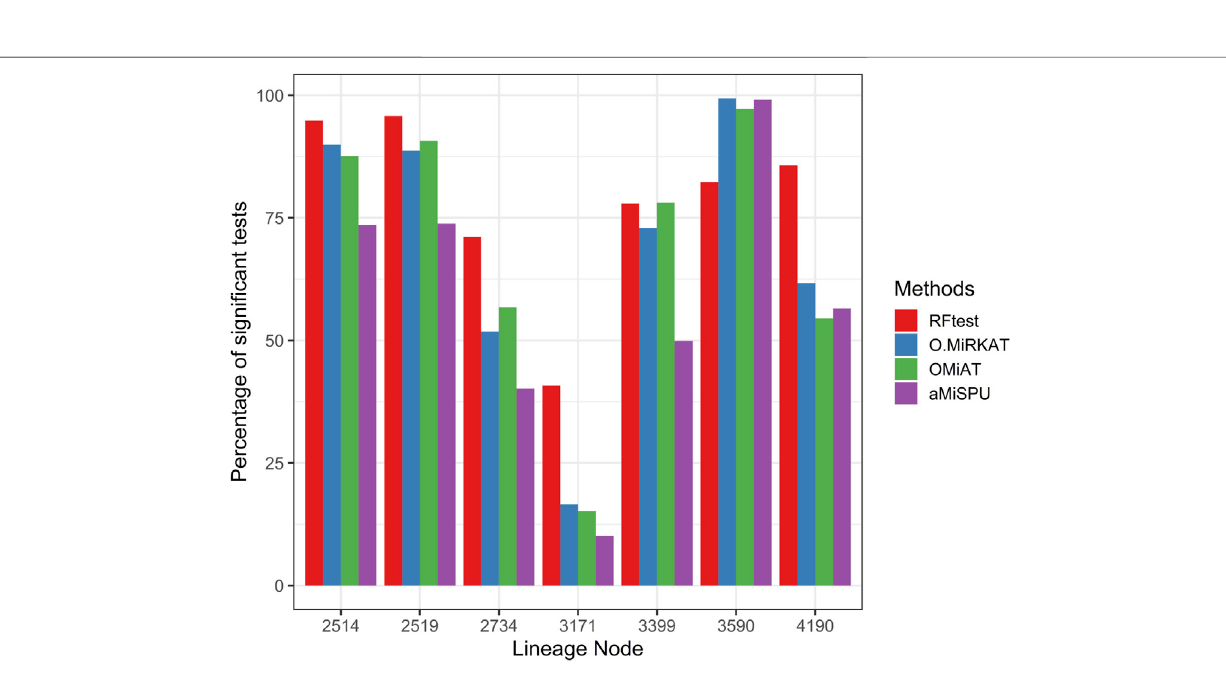
FIGURE2| Powercomparisonamongthefourcompetingmethodsundersignalsfromsevenmajorlineages.Thelineagenumberscorrespondtonodenumbersin the phylogenetic tree used in simulation in the present study. These lineages span ≥ 80% of the total OTUs and the total abundance. Abbreviations have the same meaning as in Figure 1